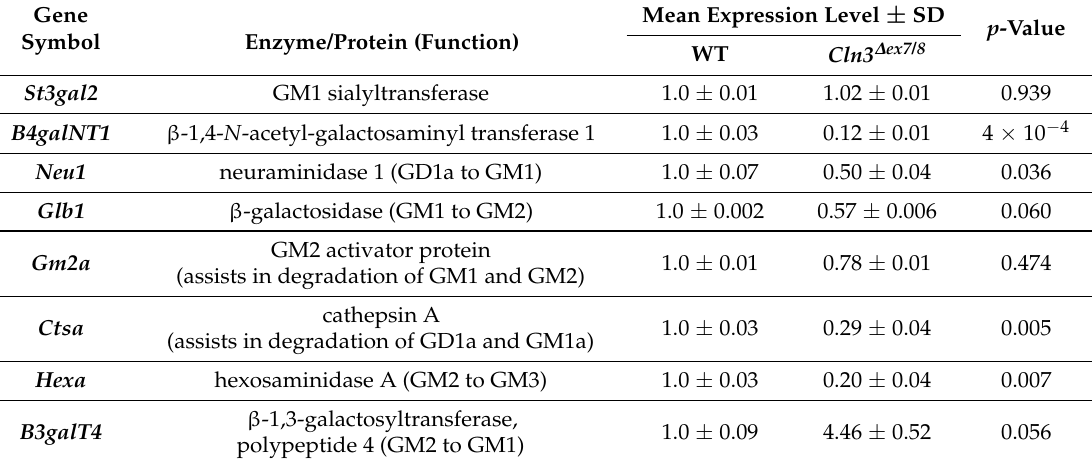
Table 2. Quantitative real-time PCR analysis of the transcript levels of genes involved in ganglioside synthesis and degradation in mouse cerebellar precursor cells. Data are a summary of three independent experiments.